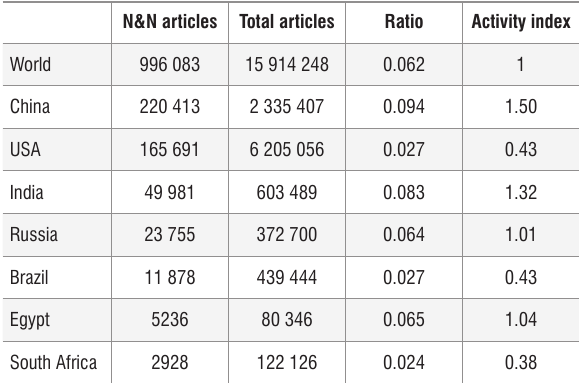
Table 2: Number of publications in the field of nanoscience and nano- technology (N&N) compared with those of selected